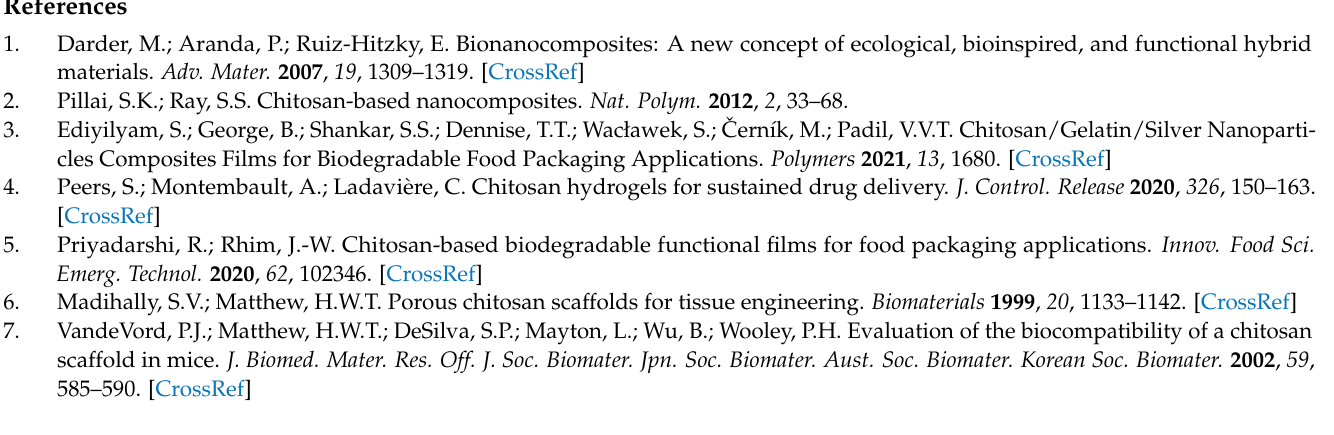
WVTR of films, Table S3: MRC of Scaffolds, Table S4: Degradation in Hank’s solution, Table S5: % of EAB of scaffolds, Table S6: Tensile strength of